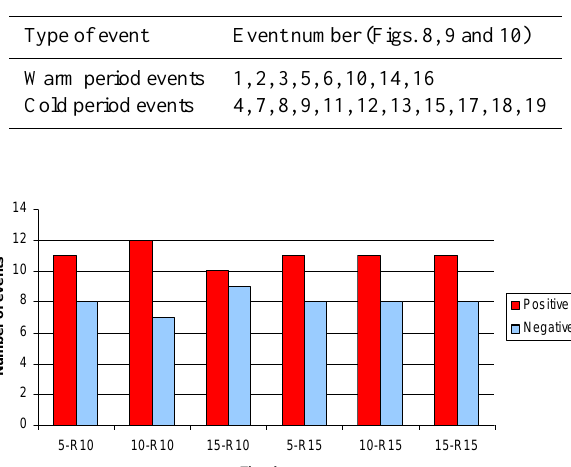
Table 2. Classification of events into warm and cold period systems.